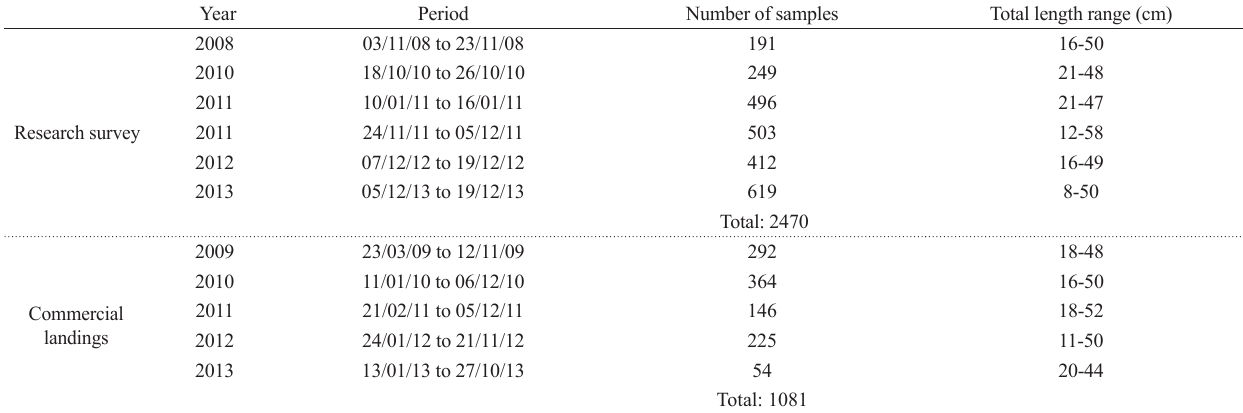
Tab. 1. Date, number and length range of Pagrus pagrus sampled during six research surveys and five years commercial landings carried out between 2008 and